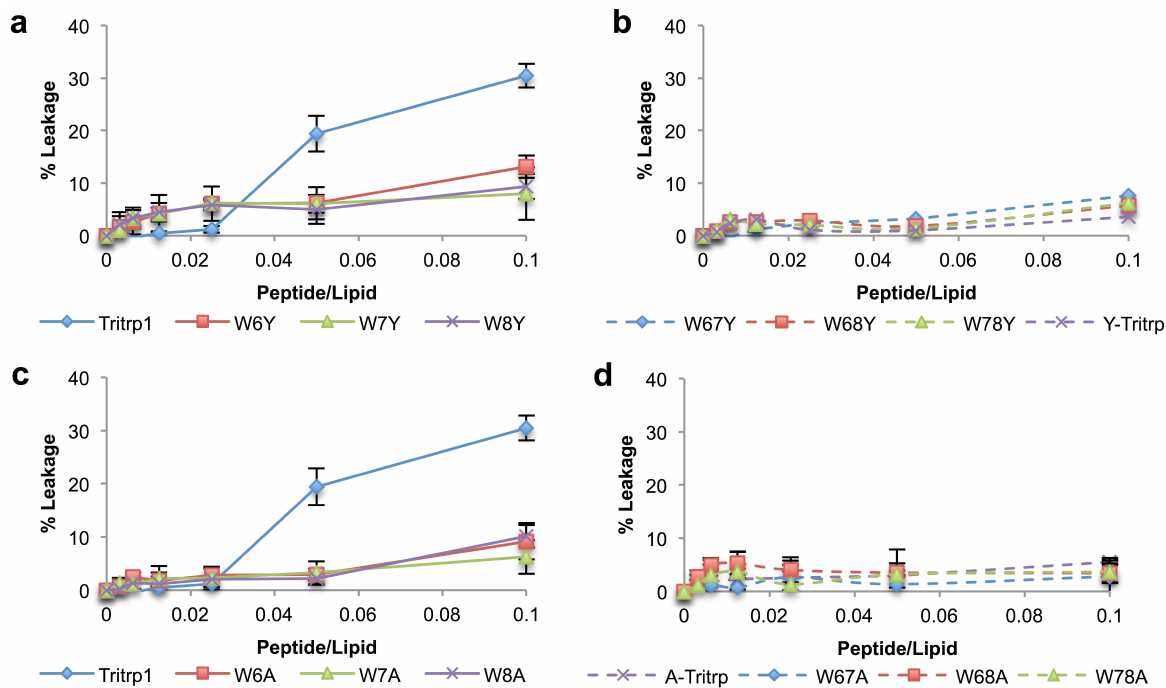
Figure 6. Calcein leakage results for Tritrp1 and its analogs in the presence of ePC:Chol (2.5:1) vesicles. Single-substituted peptides with Tyr ( a ) and Ala ( c ). Double-substituted peptides with Tyr ( b ) and Ala ( d ). Results are the mean ± SD ( n = 3).